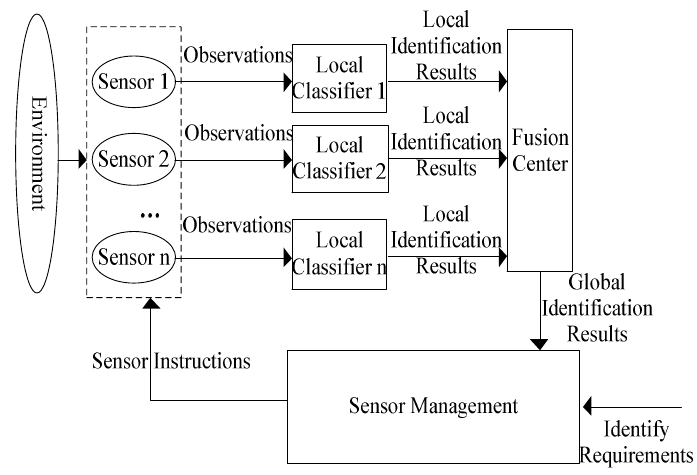
Figure 2. Target identification process with feedback.